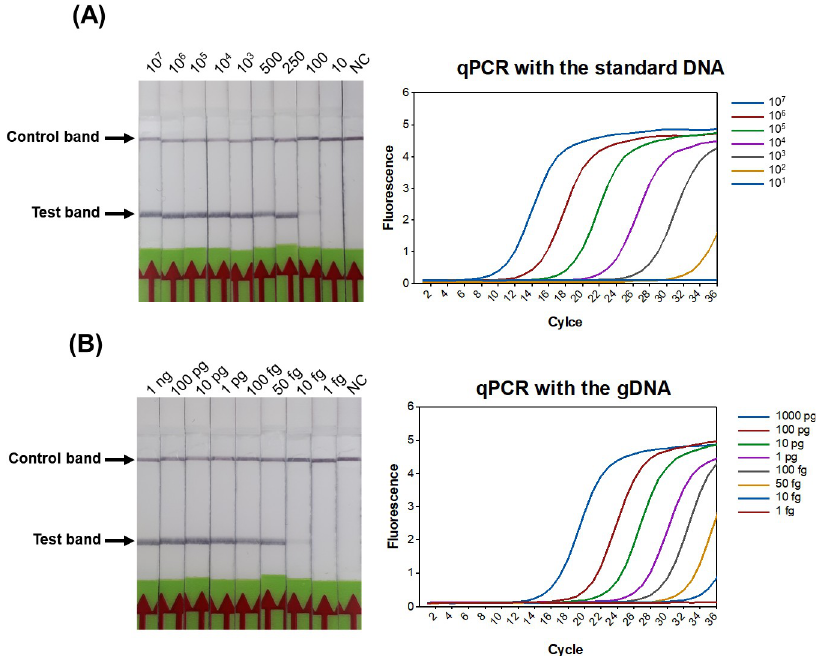
Fig 4. Comparison of the sensitivities of the RPA-LFD and real-time PCR. Molecular sensitivity of two methods was determined using serially diluted standard DNA and genomic DNA of M . ovipneumoniae . (A) Results of the RPA-LFD and real-time PCR using standard DNA as template showed a detection limit of 100 copies per reaction. (B) Results of the RPA-LFD and real-time PCR using genomic DNA of M . ovipneumoniae as template showed detection limit of 10 fg per reaction. NC; negative control (DNase-free